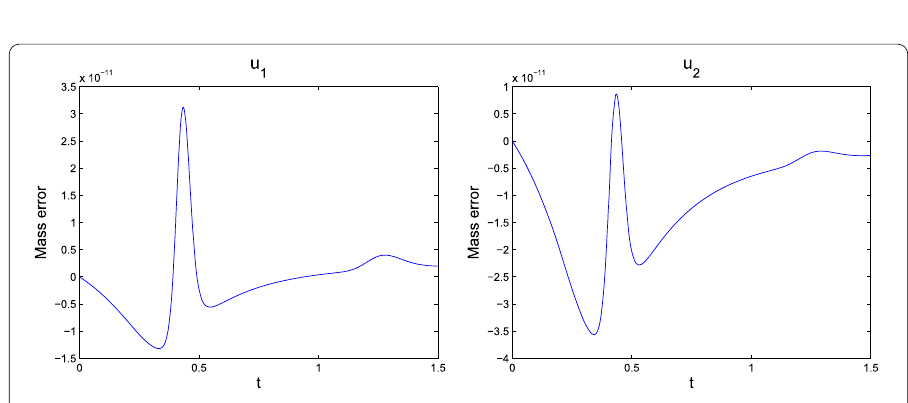
Figure 12 Traces of mass errors of solutions to system (23) with (24) using the spectral ETDRK4-P22 scheme ( α = 1.8, N = 128 and τ =